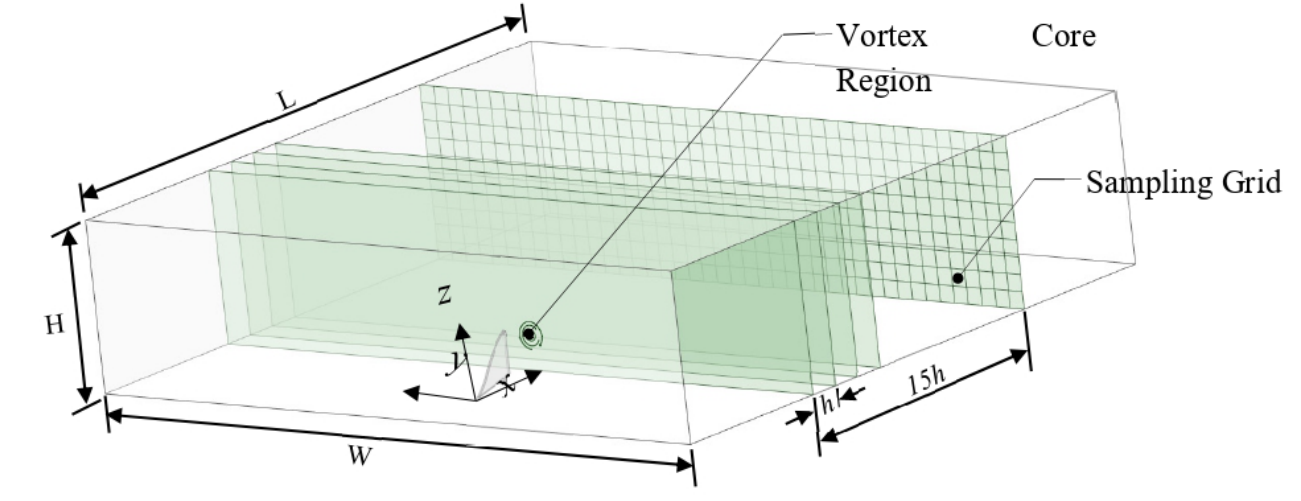
Figure 4. Rectangular, triangular, and bionic vortex generator shapes and